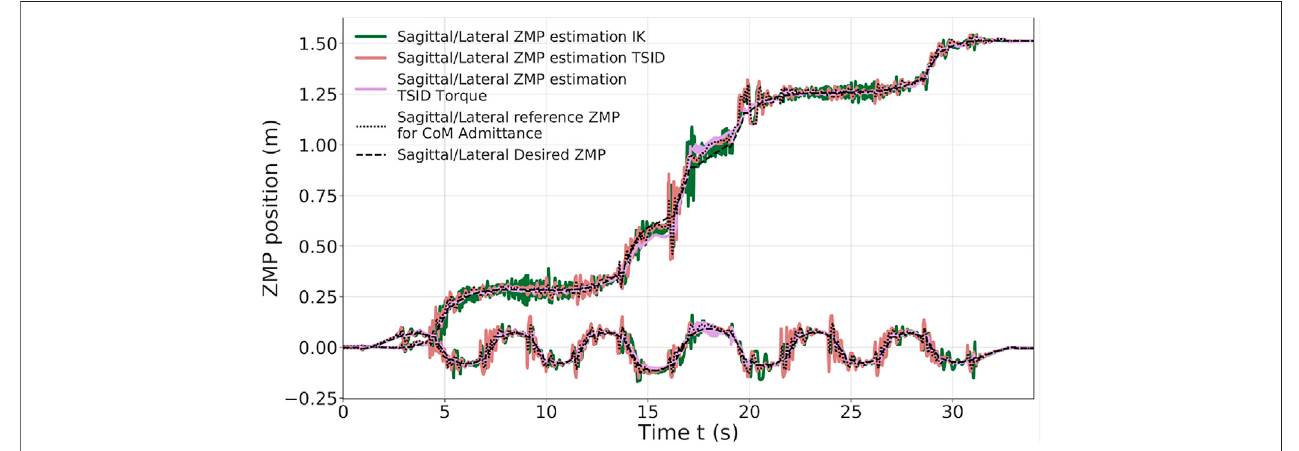
FIGURE 8 | ZMP estimation of the tilted platform simulation.